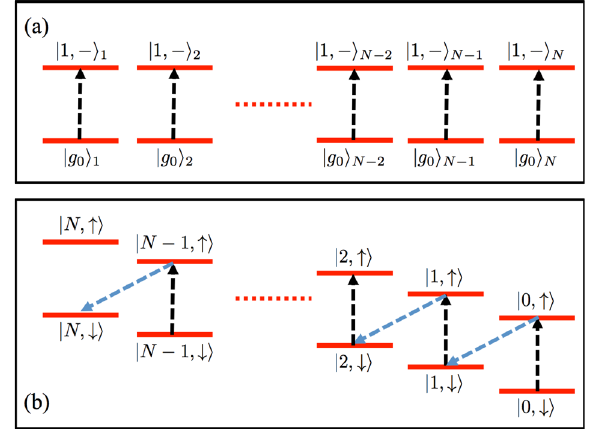
Fig. 2 Pulse sequence for state initialization. a Pulses for MI initial state at J = 0 and fi nite g . The vertical arrows are Rabi fl ips between and 1 ; (cid:2)j i in each JC model. b Pulses for SF initial the states g 0 j i state at g = 0 and fi nite J . The vertical (slanted) arrows are the operations C l ( Q l ) with l ∈ [1, N ] on the coupled system of the auxiliary qubit and mode a k = 0